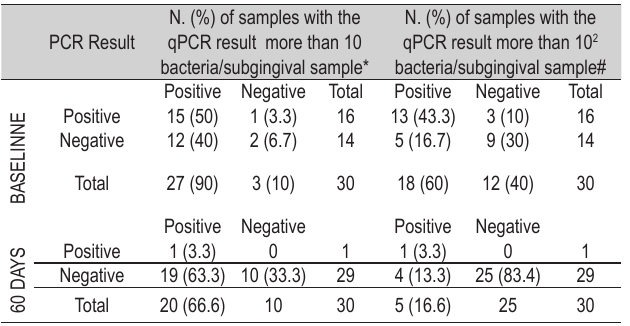
Table 2 - Comparison between PCR and qPCR for the detection of T. forsythia .